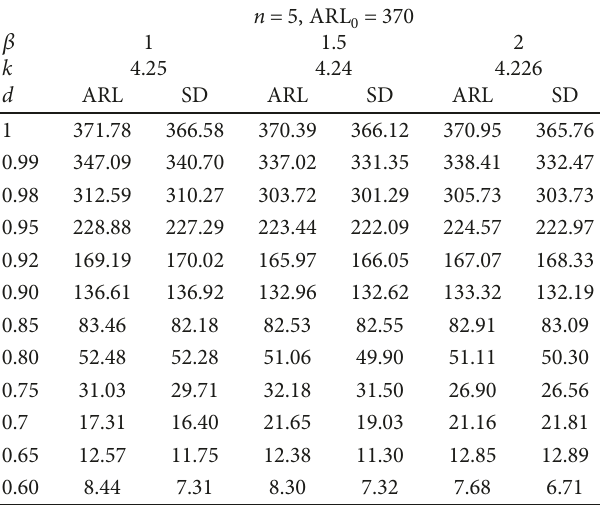
Table 4: The values of ARLs when q = 0 95 , α = 0 80 , θ = 50 , and β = 1 0,1 5,2 0 .